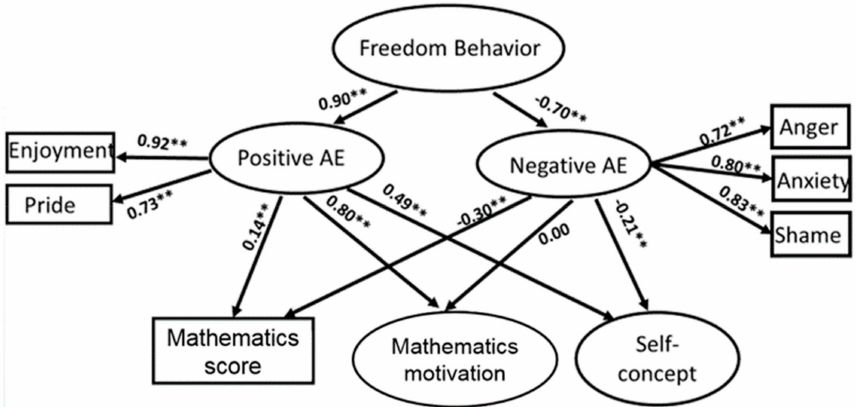
Figure 2. Impact of freedom interpersonal behavior on students’ mathematics performance through the mediation of achievement emotions (AE = mathematics achievement emotions). Note: ** p <